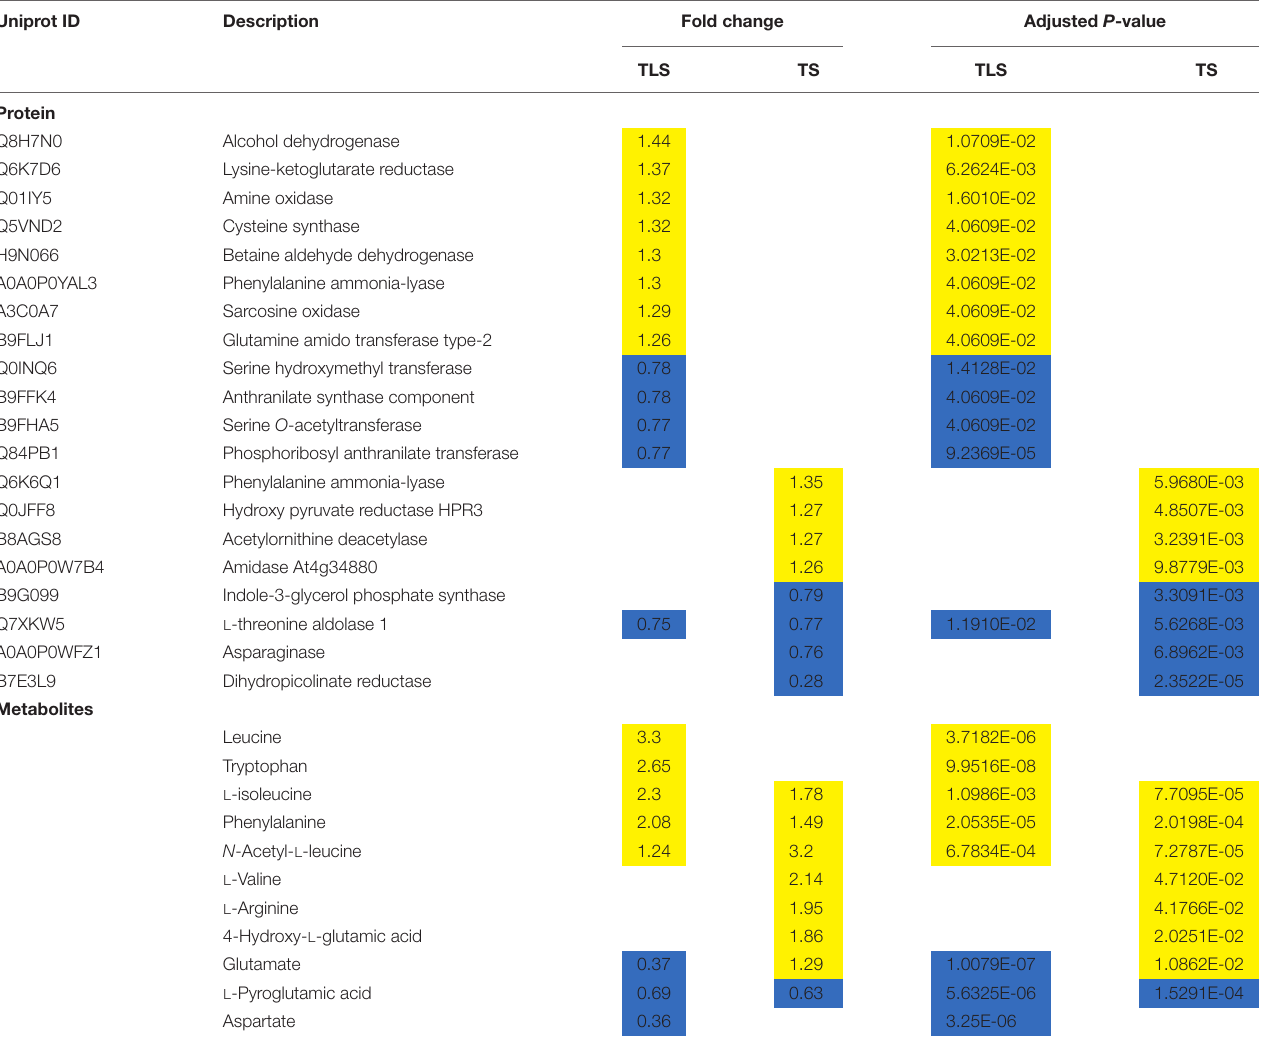
TABLE 7 | Differentially expressed proteins and metabolites related to amino acid metabolism. Uniprot ID Description Fold